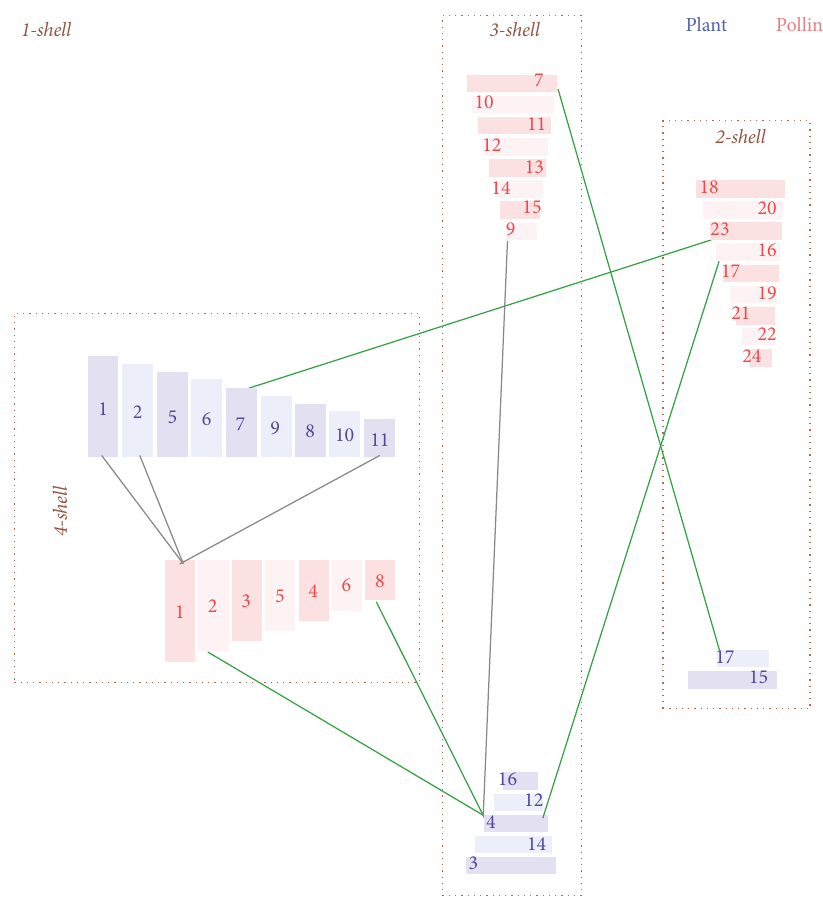
Figure 3: Building blocks of the ziggurat plot. Blue boxes represent nodes of guild 𝐴 and red boxes nodes of guild 𝐵 . The innermost core of this network is 4-shell , and node blocks are aligned with the parallel axis. ziggurats of 3-shell and 2-shell are built stacking nodes ordered by decreasing 𝑘 . Solid grey links are ties amongst nodes of 4-shell , the dotted grey link is an example of connection between two species of radius the same 𝑘 - shell , and green links connect nodes of different 𝑘 shell